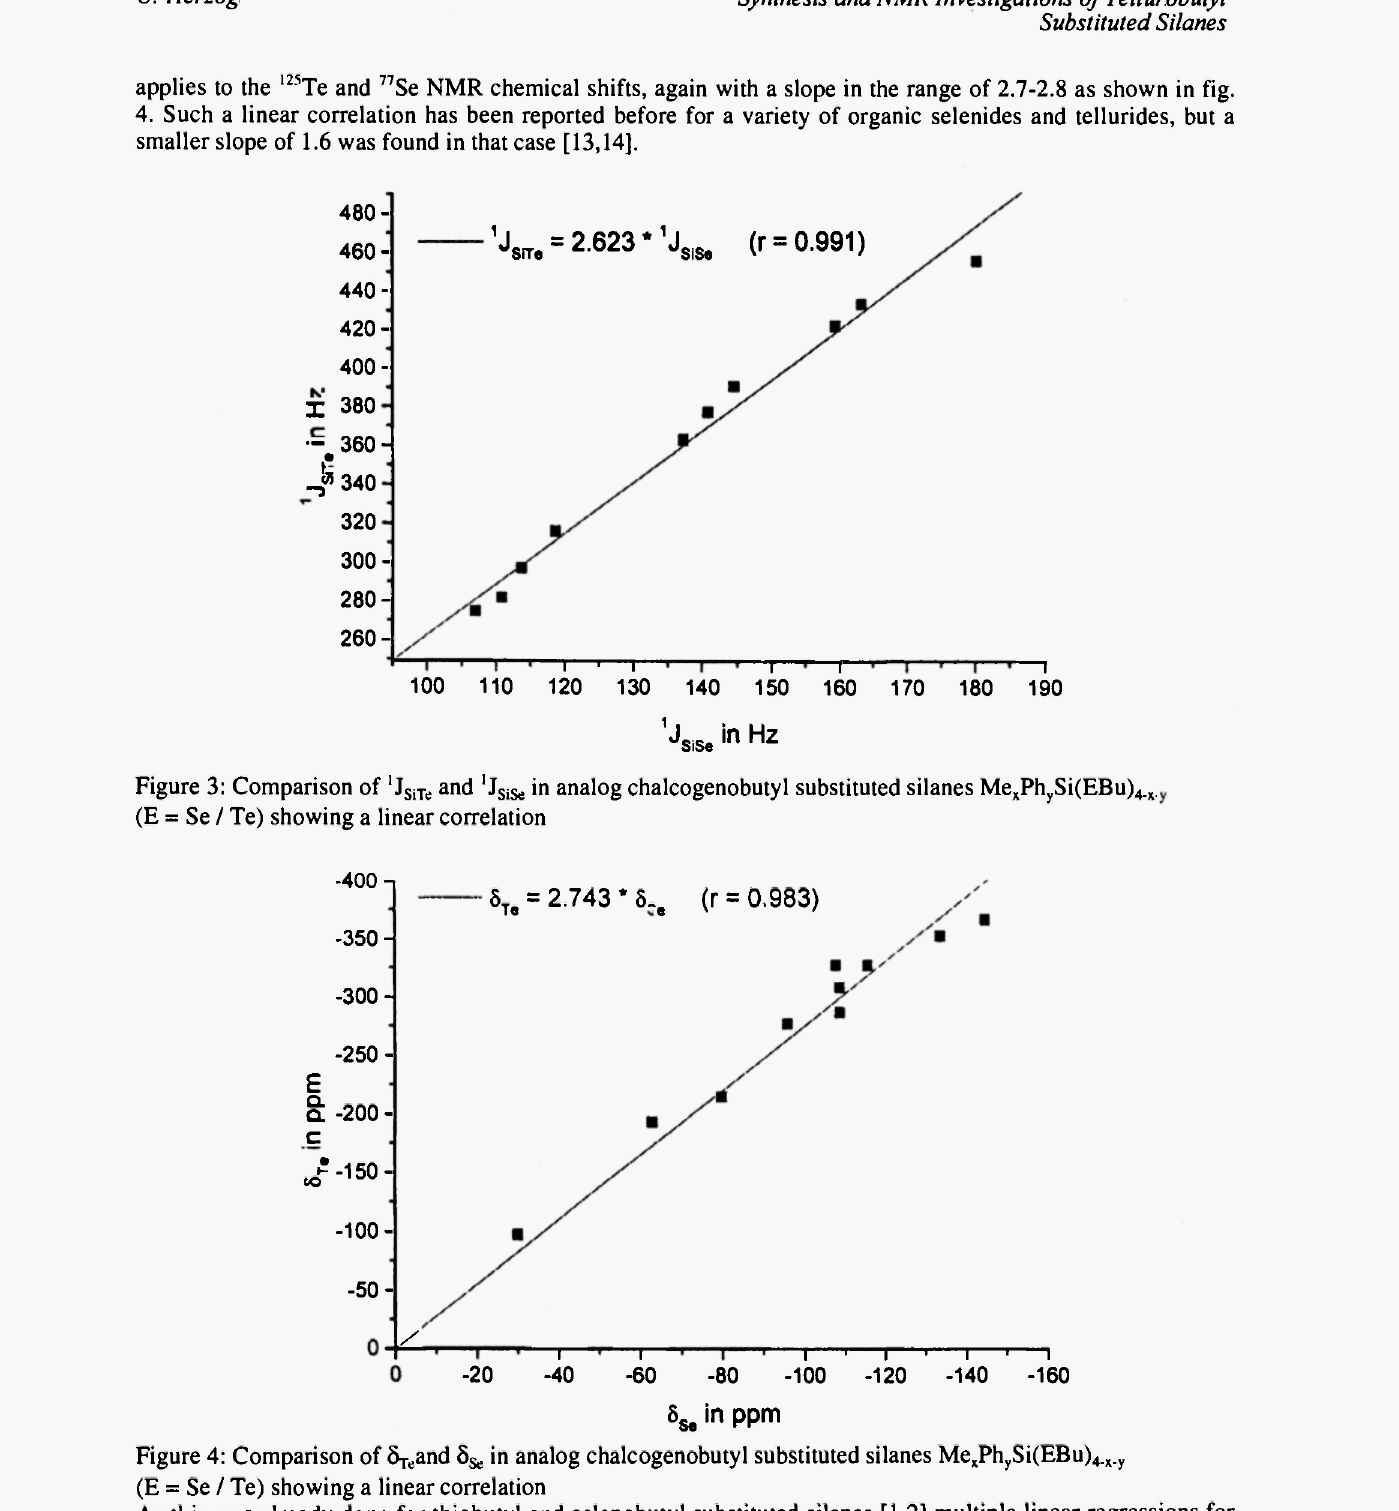
Figure 4: Comparison of S^and δ^ in analog chalcogenobutyl substituted silanes Me x Ph y Si(EBu) 4 . x . y (E = Se / Te) showing a linear